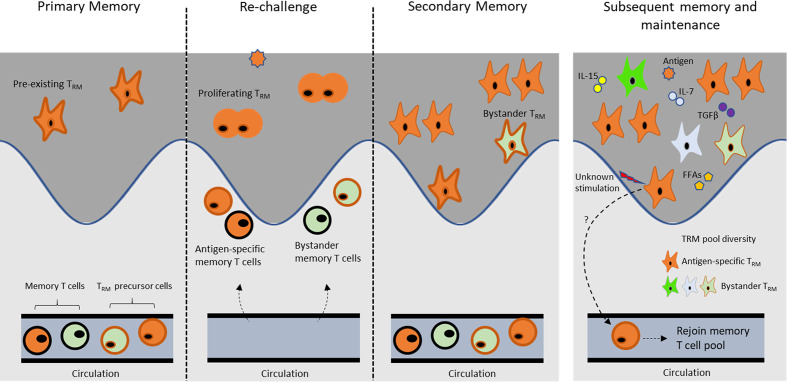
Maintenance of skin TRM cell.